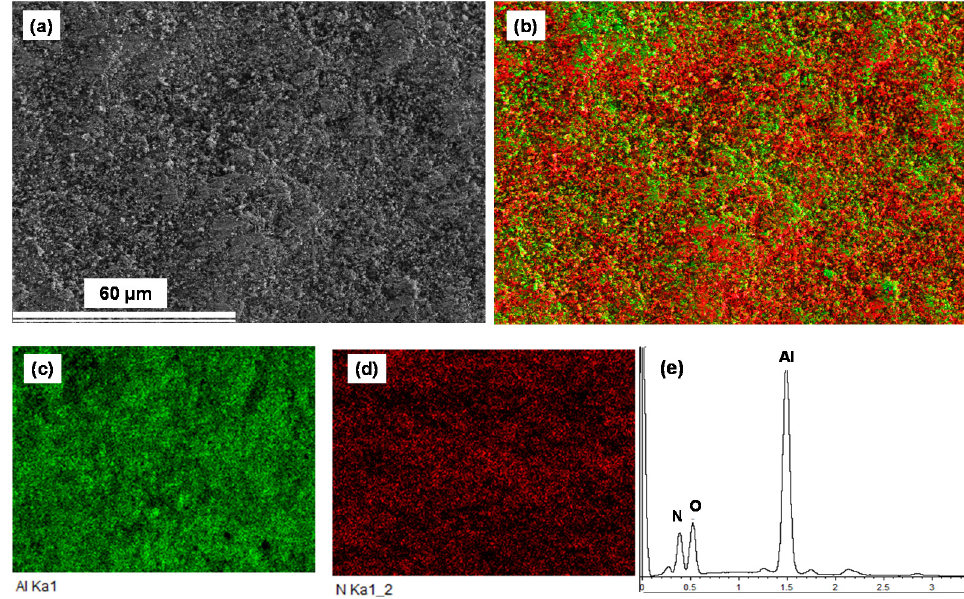
Figure 4. ( a ) A SEM image of AlN coating produced from melamine on the carbon steel substrate in X500 magnification; ( b ) the mixed EDX elemental mapping of Al and N; ( c , d ) individual elemental mapping of Al and N, and ( e ) EDX spectrum. Table 5. A summary of the atomic percentage of each element in coatings sprayed on carbon steel, Ti and Mo substrates as calculated by EDX.